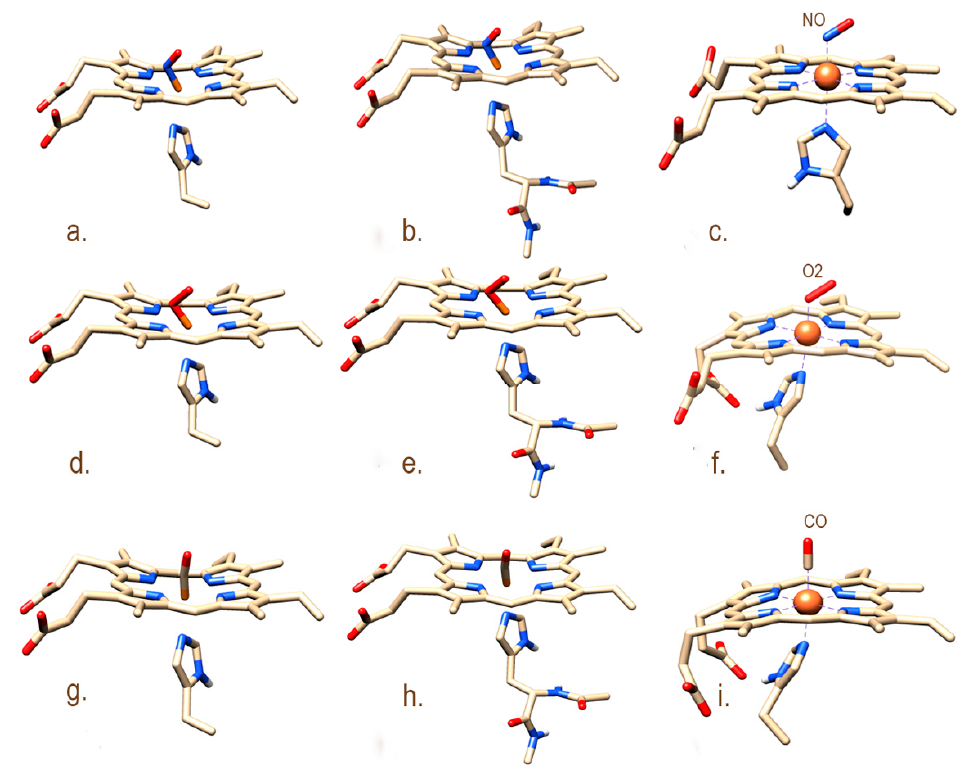
Figure 2. HNOX active site models used in the parametrization procedure. ( a , b ), ( d , e ), and ( g , h ) represent the small and large model systems of active sites His-heme-NO, His-heme-O 2 and His-heme-CO, respectively. Panels ( c , f , i ) show the optimized active site of the smaller models ( a , d , g ) that was further used for the parameterization of His-heme-NO/O 2 /CO.